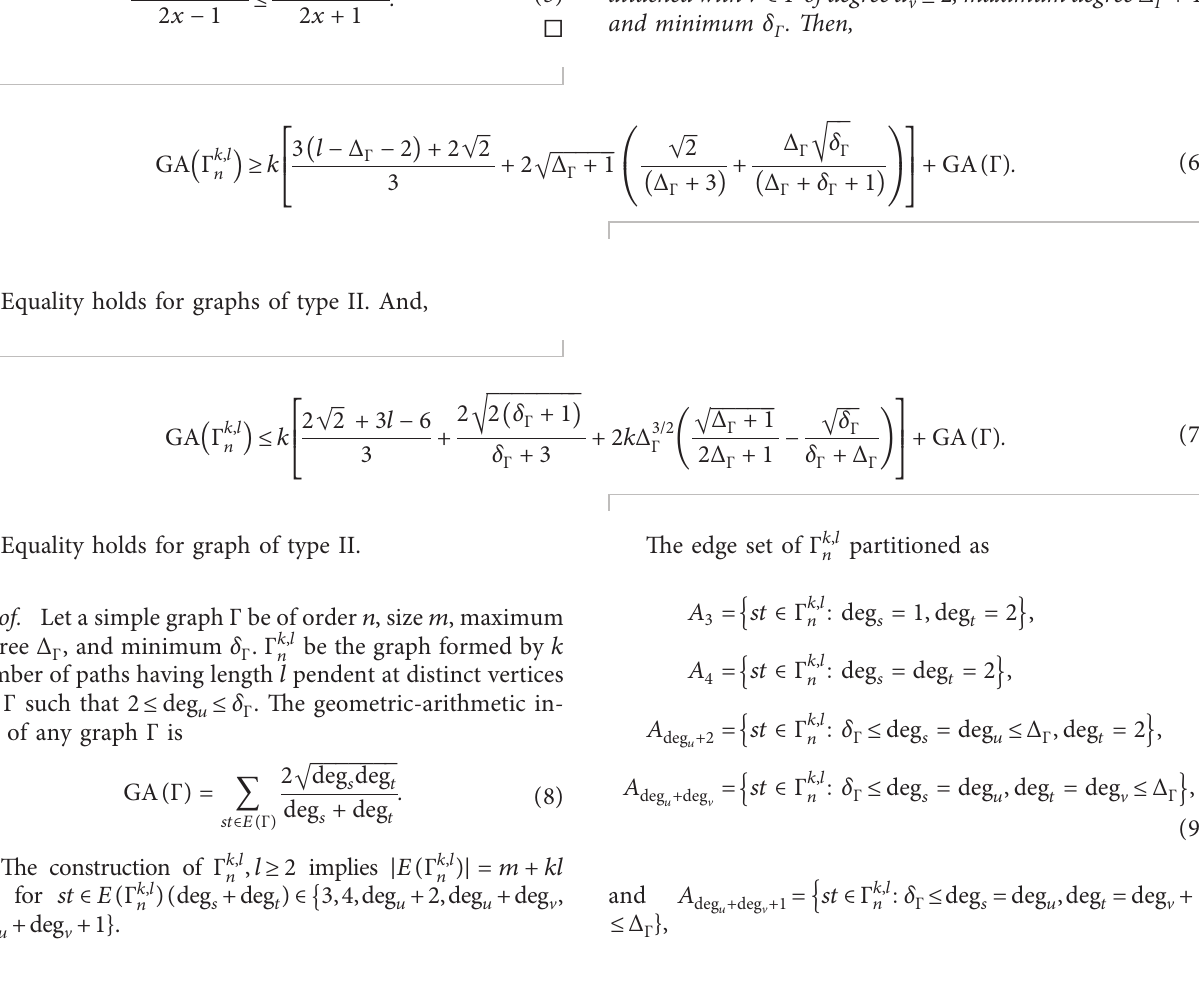
k,l n of type I. (b) Graph Γ